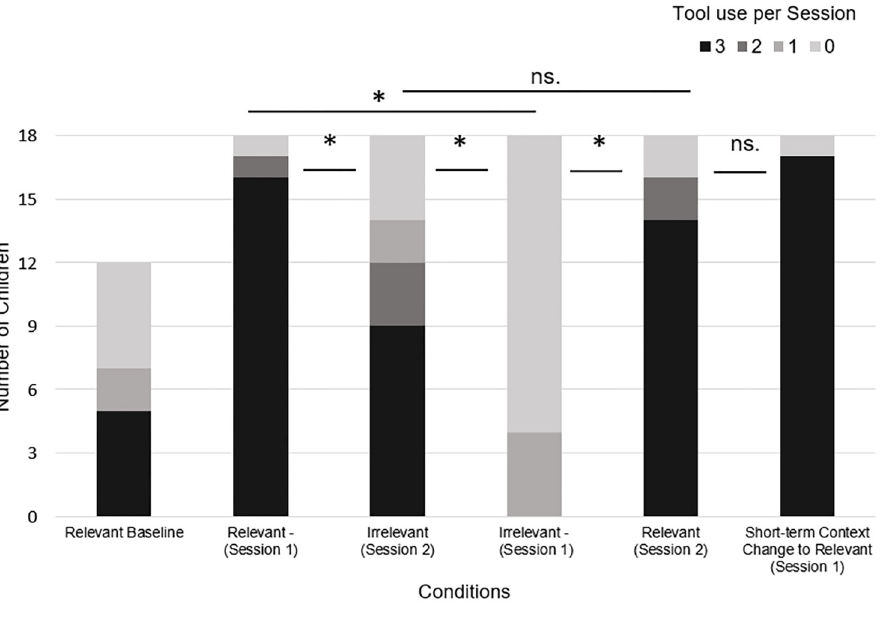
Relevant Short-term conditions. Preschoolers either used a tool or reached for the object by hand. Asterisks indicate a significant difference � p <